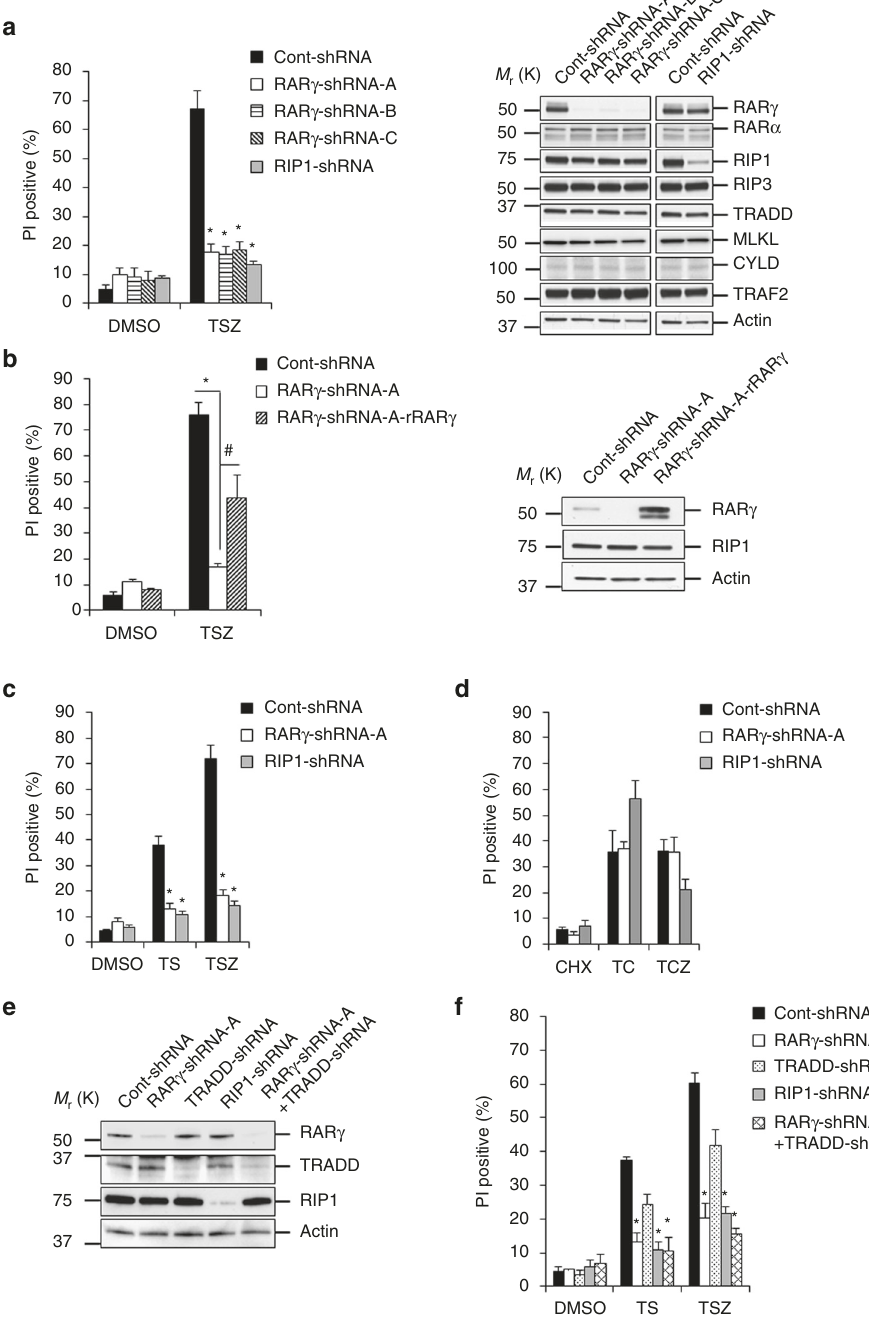
Fig. 1 RAR γ is required for TNF-induced RIP1-dependent apoptosis and necroptosis. a Cell death analysis of HT-29 clones cont-shRNA, RAR γ -shRNA-A, RAR γ -shRNA-B, RAR γ -shRNA-C or RIP1-shRNA when treated with TSZ for 24 h was determined by PI staining using fl ow cytometry ( left panel ) (* P < 0.05 versus cont-shRNA; ANOVA). The bars represent the mean ± s.e.m. of three experiments. Western blot analysis of cells as mentioned in left panel ; cell lysates were probed with antibodies as indicated ( right panel ). b Cell death determination by PI staining using fl ow cytometry of HT-29 cont-shRNA, RAR γ -shRNA-A or RAR γ -shRNA-A cells reconstituted with RAR γ -shRNA resistant RAR γ protein (RAR γ -shRNA-A-rRAR γ ) when treated with DMSO or TSZ for 24 h ( left panel ) (* P < 0.05 versus cont-shRNA. # P < 0.05 versus RAR γ -shRNA-A; ANOVA). The bars represent the mean ± s.e.m. of three experiments. Western blot analysis of cells as mentioned in left panel; cell lysates were probed with antibodies as indicated ( right panel ). c , d HT-29, RAR γ -shRNA-A, or RIP1-shRNA cells were treated with necrotic (DMSO, TS, or TSZ) c or apoptotic (CHX, TC or TCZ) d conditions for 24 h. PI positive population was determined by fl ow cytometry. (* P < 0.05 versus cont-shRNA; ANOVA). The bars represent the mean ± s.e.m. of three experiments. e Western blot analysis of HT-29 cont-shRNA cells infected with TRADD-shRNA, or RAR γ -shRNA-A cells infected with TRADD-shRNA lentivirus (RAR γ -shRNA-A + TRADD-shRNA). Cell lysates were probed with antibodies as indicated. f Cells from e were treated with DMSO, TS, or TSZ for 24 h and the PI-positive population was determined by fl ow cytometry. (* P < 0.05 versus cont-shRNA; ANOVA). The bars represent the mean ± s.e.m. of three experiments. All blots above are representative of one of three